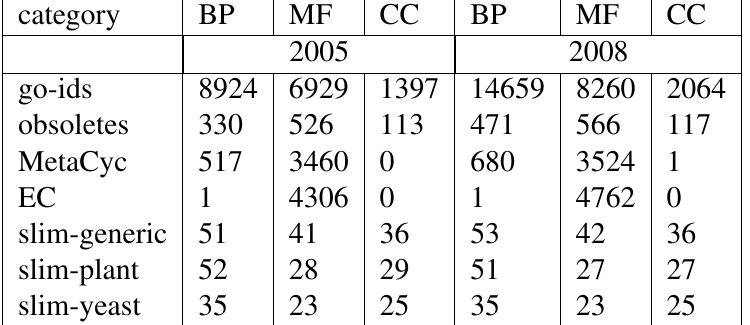
Table 1: GO-Statistics: Gene Ontology statistics for the three main categories, biological process (BP), molecular function (MF) and cellular component (CC). Data are taken from the obo files taken from the geneontology website for 2005 (January) and 2008 (April). Shown are the numbers of GO-ids, obsolete GO-ids, the number of GO-ids annotated with MetaCyc-terms or EC-numbers and the number of GO-ids for the GO-slims generic, plant and